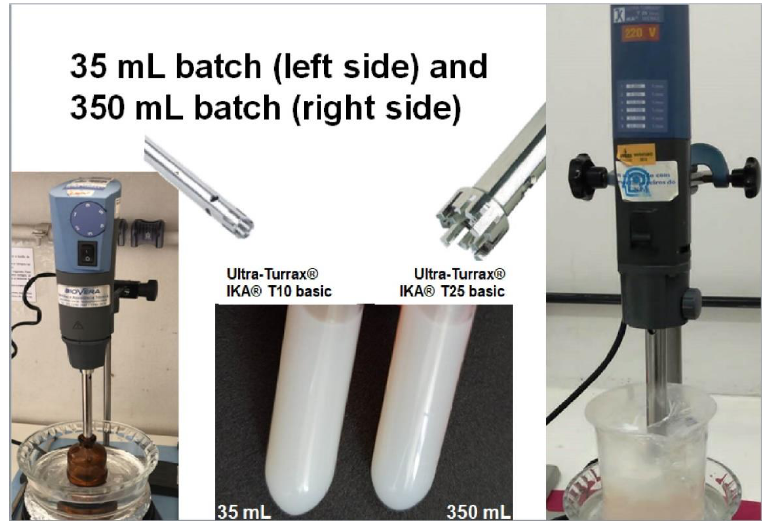
Figure 5. Preparation of 35 mL nanoemulsion batches under heat using a T10 basic Ultra-Turrax ® IKA ( left ) and a process scale-up to 350 mL batches using a T25 basic Ultra-Turrax ® IKA ( right ). The middle panel shows the disperser tools of each piece of equipment and the appearance of formula- tions.